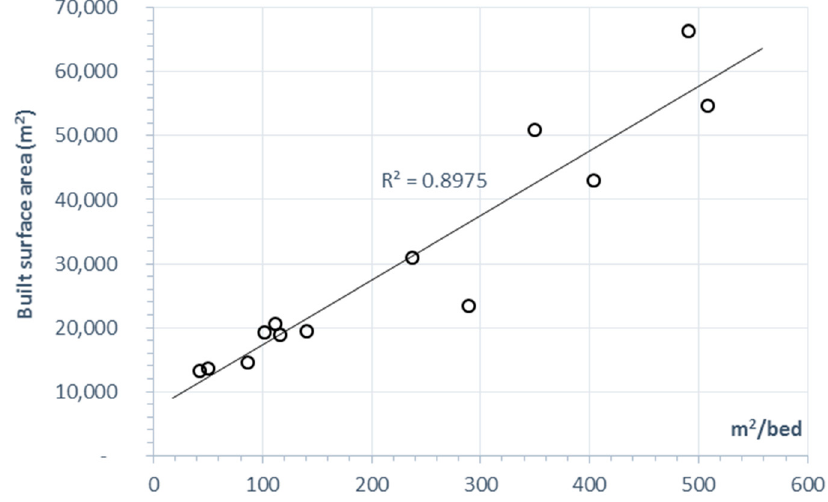
Figure 1. Relationship between the built surface area and the number of beds.